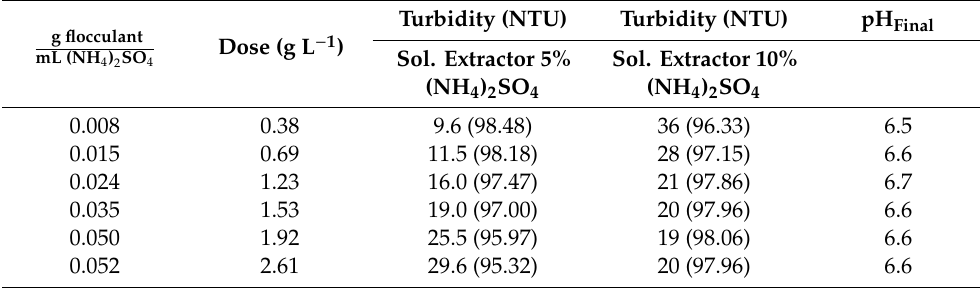
Note: NTU: nephelometric turbidity units.